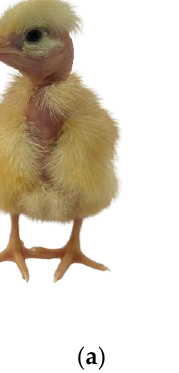
Figure 4. Naked neck birds. ( a ) Young heterozygous naked neck chick with a small tuft of fathers on the neck. ( b ) Adult heterozygous naked neck animal with a small tuft of fathers on the neck.